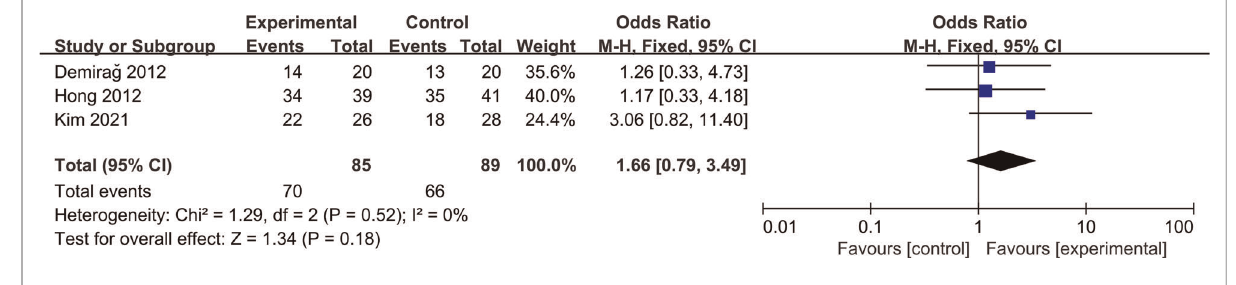
FIGURE 7 Forest pot for Lachman